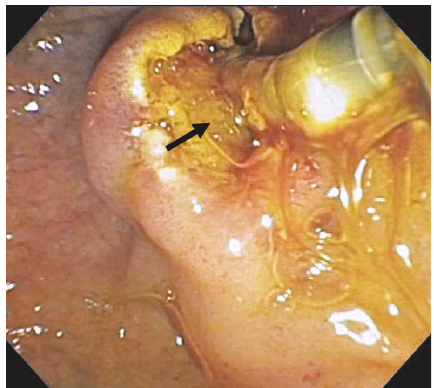
Figure 1: Case # 1, Sludge (arrow) coming from ampulla after sphincterotomy during